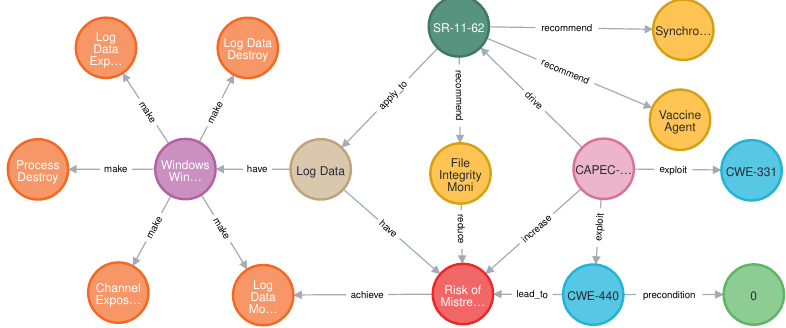
Figure 7. Visualized AG-PDO instance generated by the Neo4j